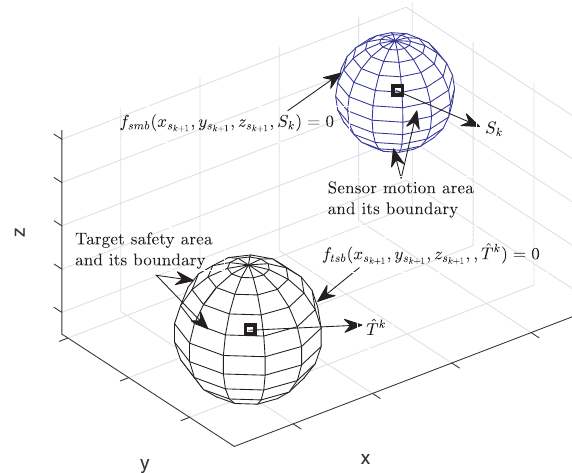
Figure 2. Sensor motion area and target safety